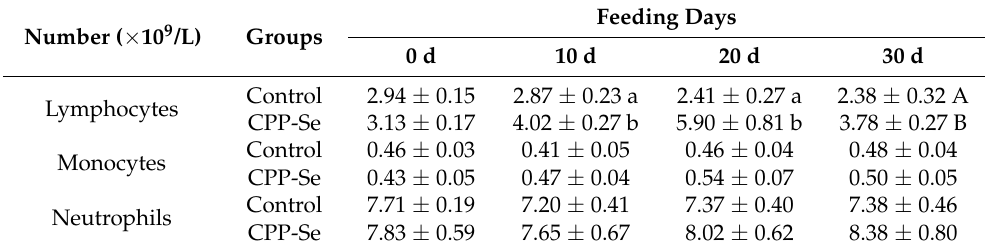
Table 2. Effects of CPP-Se on the number of blood immune cells in dogs.